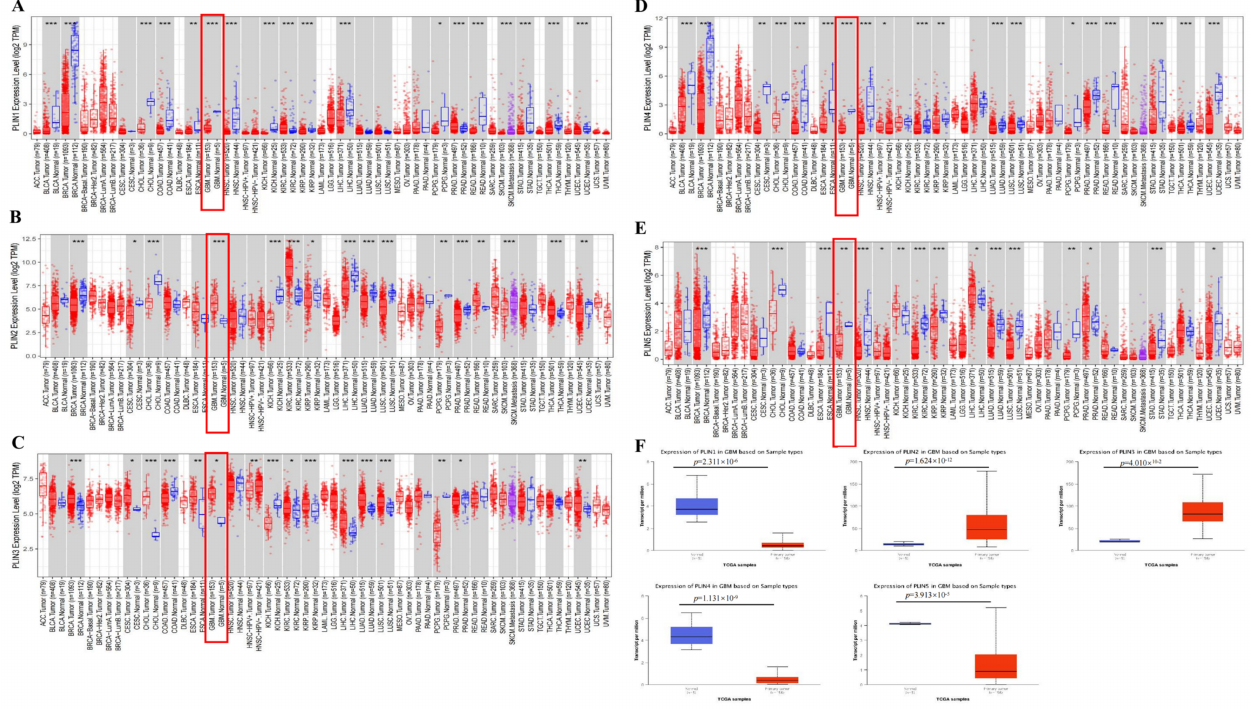
Figure 1. PLINs family members’ mRNA expression in pan-cancer. ( A – E ) Expression levels of per- ilipin members ( PLINs) gene in pan-cancer according to TIMER2.0 database. * p < 0.05; ** p < 0.01; *** p < 0.001. ( F ) Expression levels of PLINs gene in tumor and normal tissues based on UAL- CAN database.